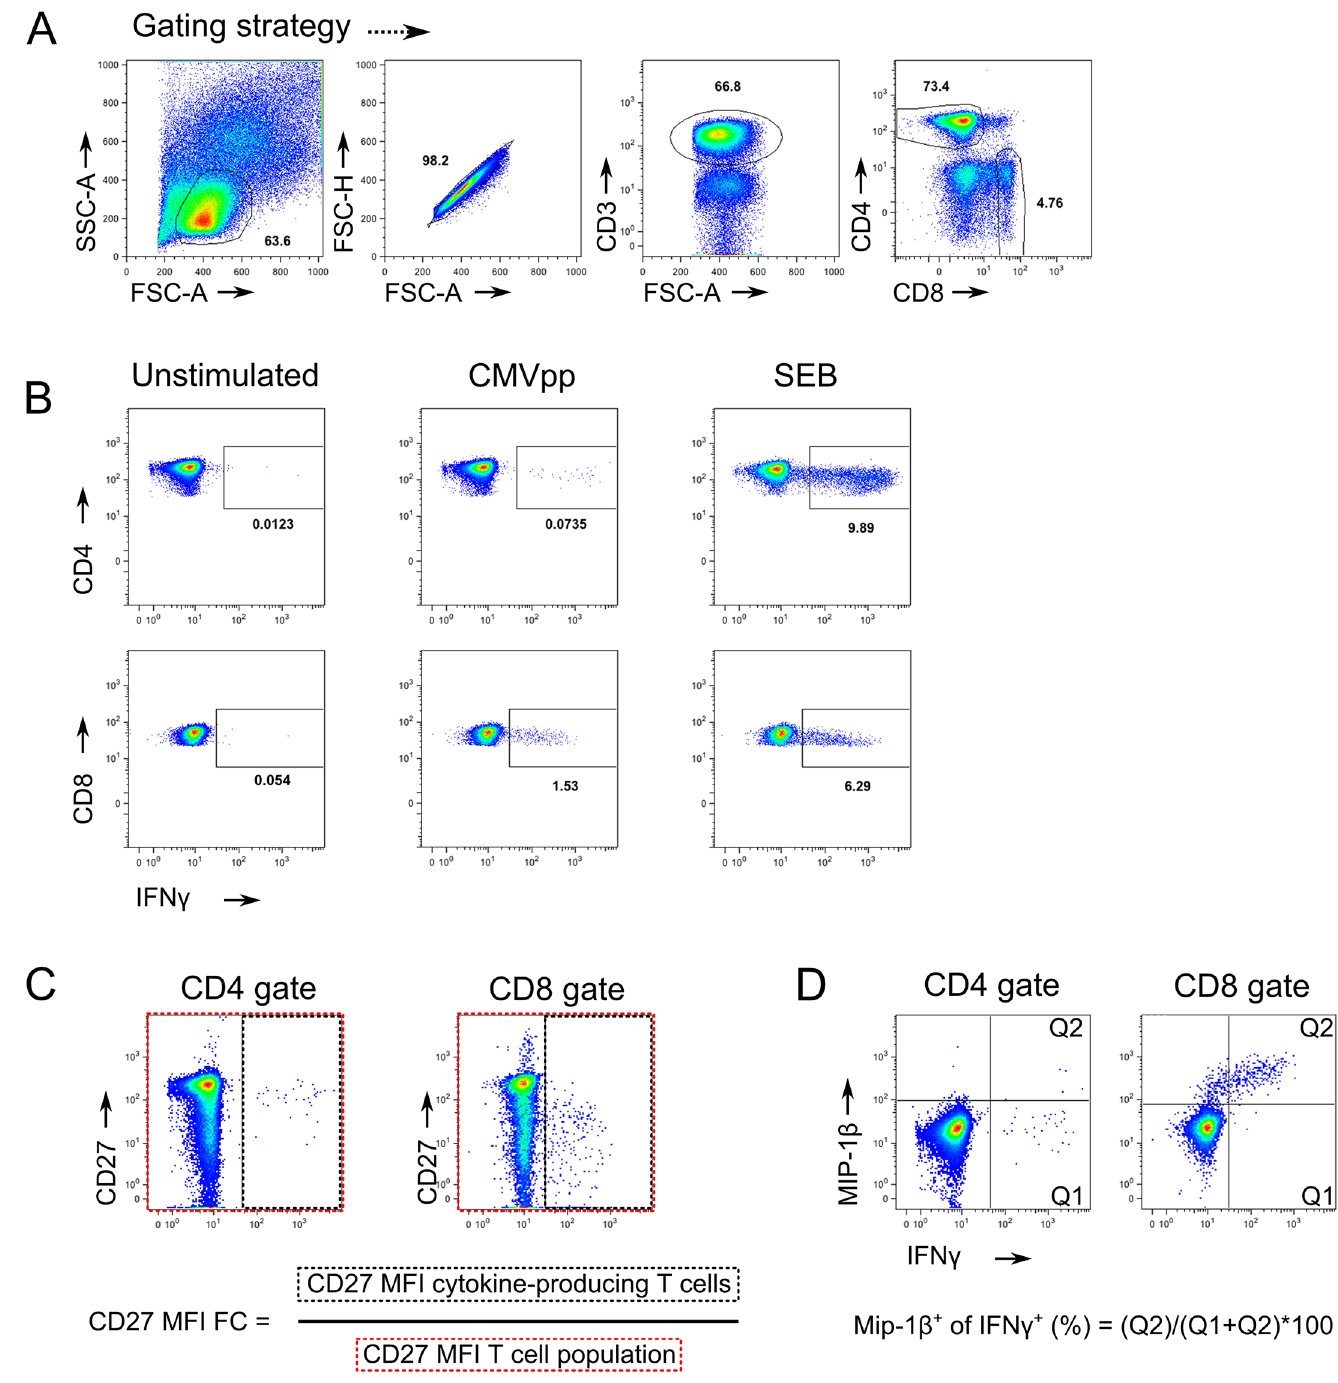
Fig 1. Gating strategies and CMV responses evaluation. A) Morphological and CD marker expression gating strategy of CD4 and CD8 T cell. B) Representative CD4 and CD8 T cell IFN γ response from a significant responder. C) Gating strategy for the CD27 MFI Fold Change calculation of IFN γ producing cells compared to all CD4 or CD8 T cells. D) Gating strategy for the determination of IFN γ producing cells that were also positive for Mip1 β production.